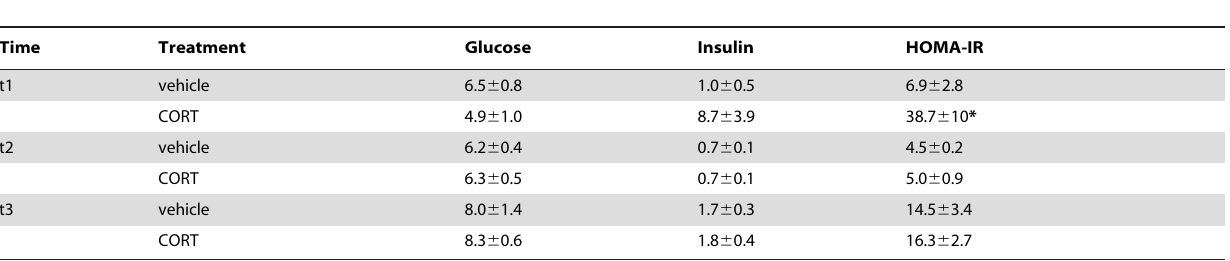
CORT: corticosterone; HOMA-IR: homeostasis model assessment of insulin resistance index * P , 0.05.